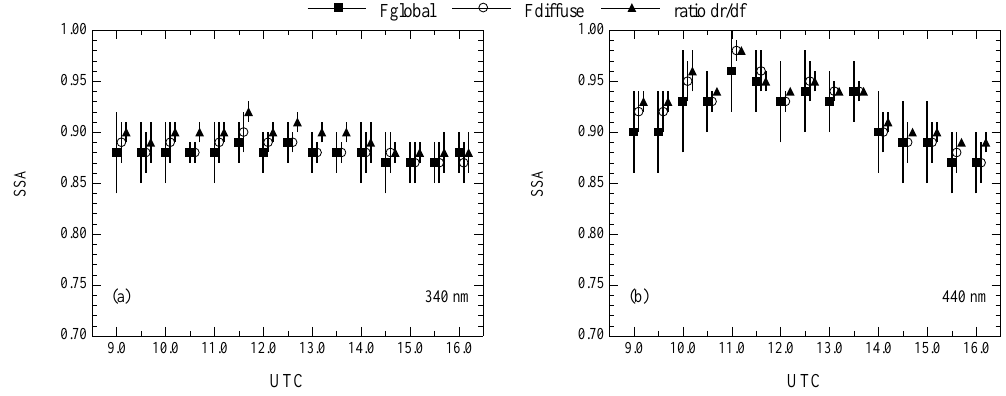
Fig. 1. Daily variations of SSA retrieved from global (square), diffuse (circle) and the direct-to-diffuse ratio (triangleup) measured by the spectroradiometer on 11 September 2006: (a) at 340nm; (b) at 440nm. Vertical bars correspond to the standard deviation around the mean SSA computed over 5nm around the central wavelength (see text).